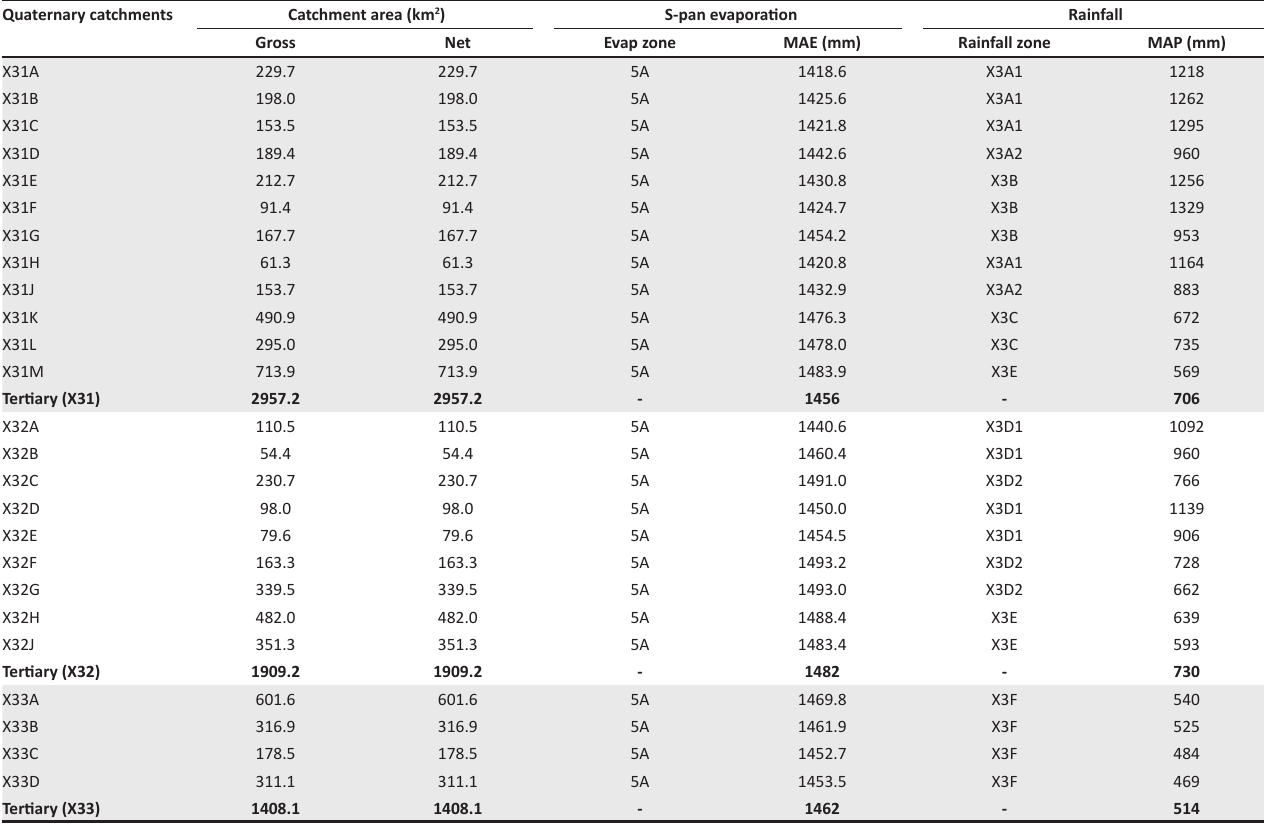
TABLE 1: Quaternary catchments and rainfall zones of the Sabie River catchment. Quaternary